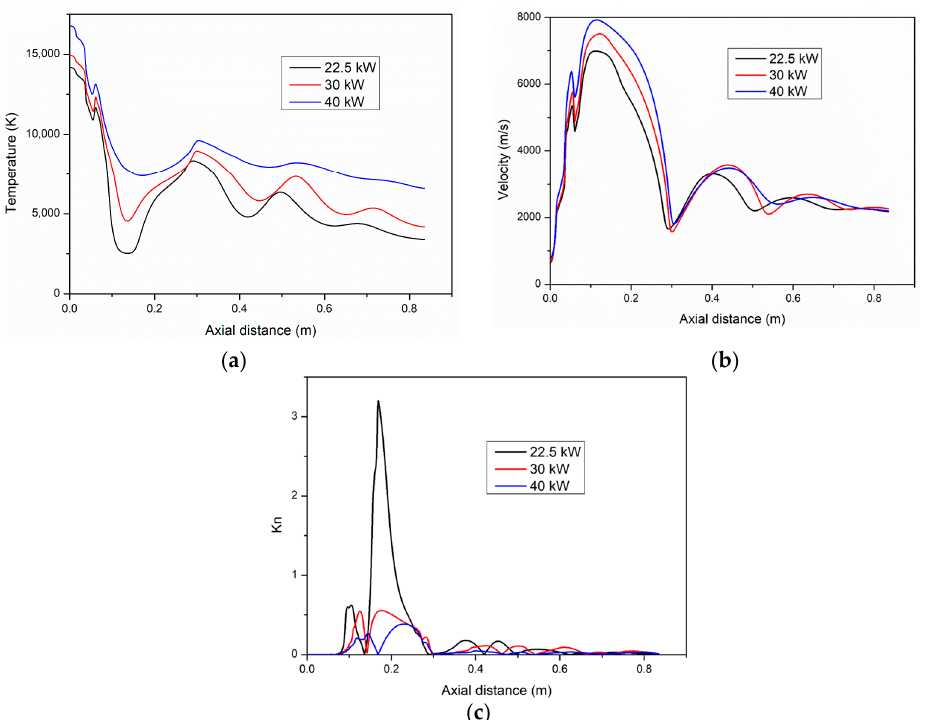
Figure 7. Variation of the 40Ar–8H 2 plasma jet ( a ) temperature, ( b ) velocity, and ( c ) Knudsen number along the torch axis for different net powers at 100 Pa.